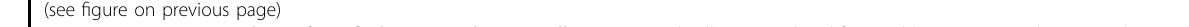
Fig. 3 In vivo image analysis of puri fi ed V4( + ) and V4( − ) cells. a Peritoneal cells were isolated from wild-type mice, and V4( + ) and V4( − ) cells were puri fi ed using anti-VSIG4 or anti-CD11b antibody and MACS MicroBeads. Cells purity >90% was obtained. b V4( + ) and V4( − ) cells were stained with VivoTracker, and the stained cells were injected into the peritoneal cavities of CLP mice. After 24 h, the mice were euthanized, and the peritoneal cavity was washed with PBS three times. Then, the fl uorescence intensities of different organs were detected with an In Vivo Imaging System. c The thymus was only isolated from V4( − ) cell-injected mice, but the thymus from V4( + ) cell-injected mice showed severe contraction, so it was isolated with the surrounding tissue and analyzed with an IVIS. d After IVIS analysis, thymocytes were puri fi ed, and cells were stained with CD4 and CD8 antibodies, and analyzed by fl ow cytometry. e The data indicates the percentage of CD4/CD8 DP cells. f After IVIS analysis, immune cells isolated from the peritoneal cavity and thymus were stained with CD11b and VSIG4 antibodies, and analyzed by fl ow cytometry. g Peritoneal cells and thymocytes as shown in ( b ) were isolated and analyzed with an IVIS. h Number of VivoTracker positive cells from peritoneal cavity and i thymus as shown in ( b ) were counted using Alexa 700. j CD11b + cells from thymus as shown in ( f ) were counted. The data represent the mean ± S.E.M. of three separate experiments. * p < 0.05, ** p < 0.01, ANOVA. V4 indicates VSIG4, and VTK indicates the activity of